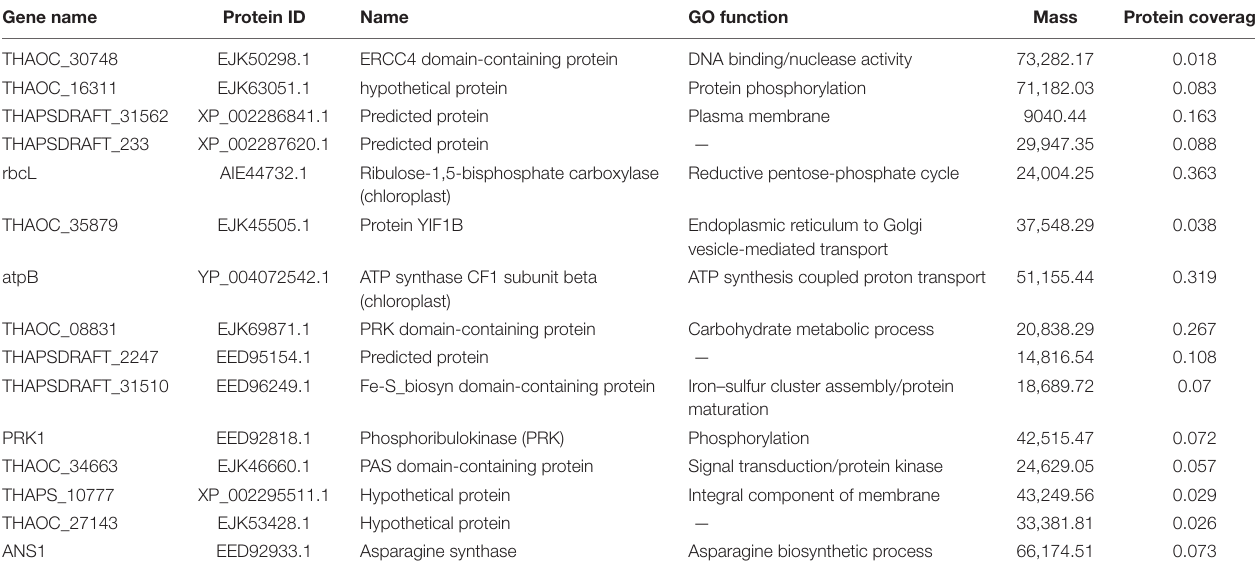
TABLE 1 | The protein chemo markers responsible for the discrimination of four sample